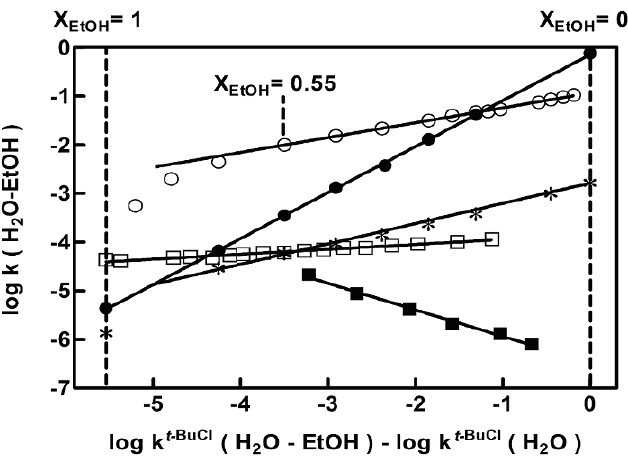
Figure 1. Plots of log k for reactions vs log k t-BuCl for the solvolysis of tert -butyl chloride (2-chloro-2-methylpropane) in binary water-ethanol mixtures at 25 o C [35]. ○ -alkaline hydrolysis of ethyl acetate [40], ● -solvolysis of 2-bromo-2-methylpropane [41], ∗ -solvolysis of benzoyl fluoride [42], □ -reaction between 1-chloro-2,4-dinitrobenzene and aniline [43], ■ -decomposition of trimethylsulfonium ion